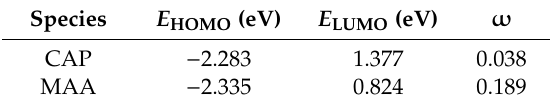
Figure 3. Frontier molecular orbitals (FMOs) and energy levels for highest occupied molecular orbitals (HOMOs) (top) and lowest unoccupied molecular orbital (LUMOs) (bottom) of the template CAP and monomer MAA. Table 1. Frontier orbital parameters: E HOMO , E LUMO , and ω of CAP and